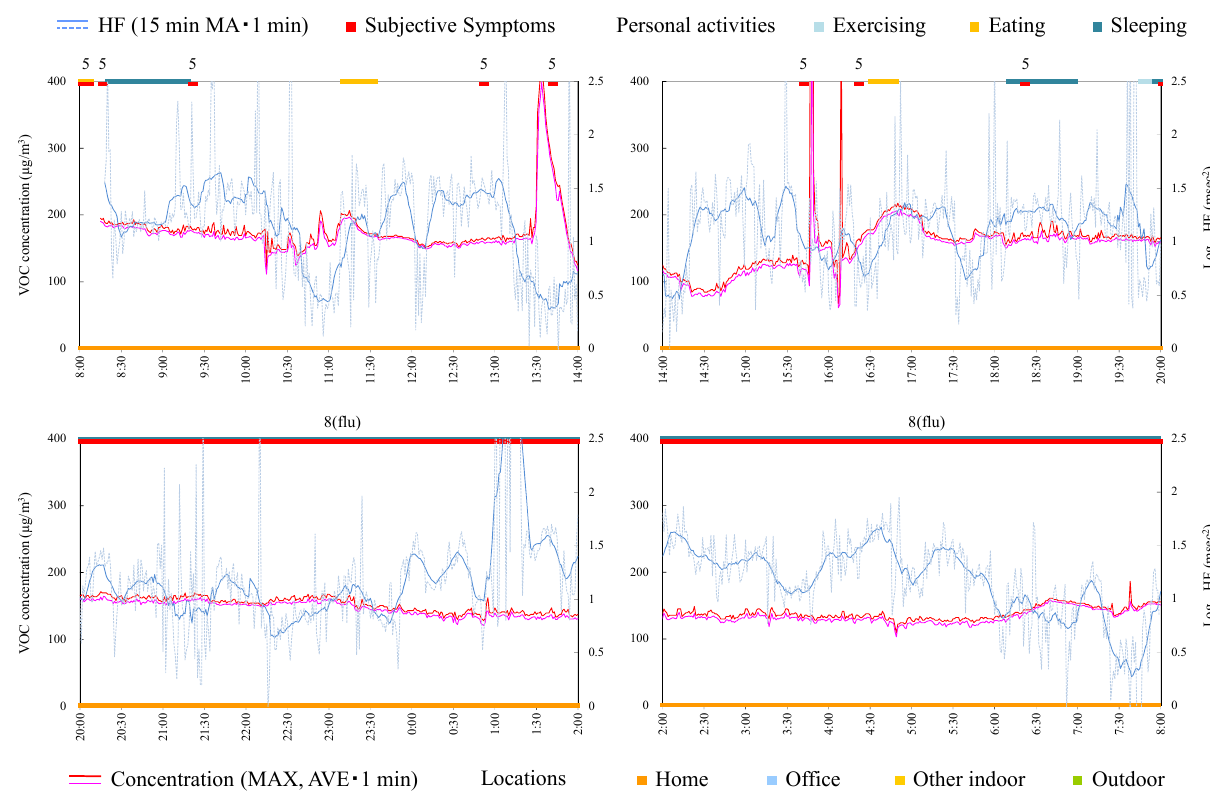
Figure 6. Time-series data of VOC concentration and log 10 HF (subject D). Subjective symptoms and personal activities are indicated in upper side and locations are indicated in lower side. The values on subjective symptoms are symptom